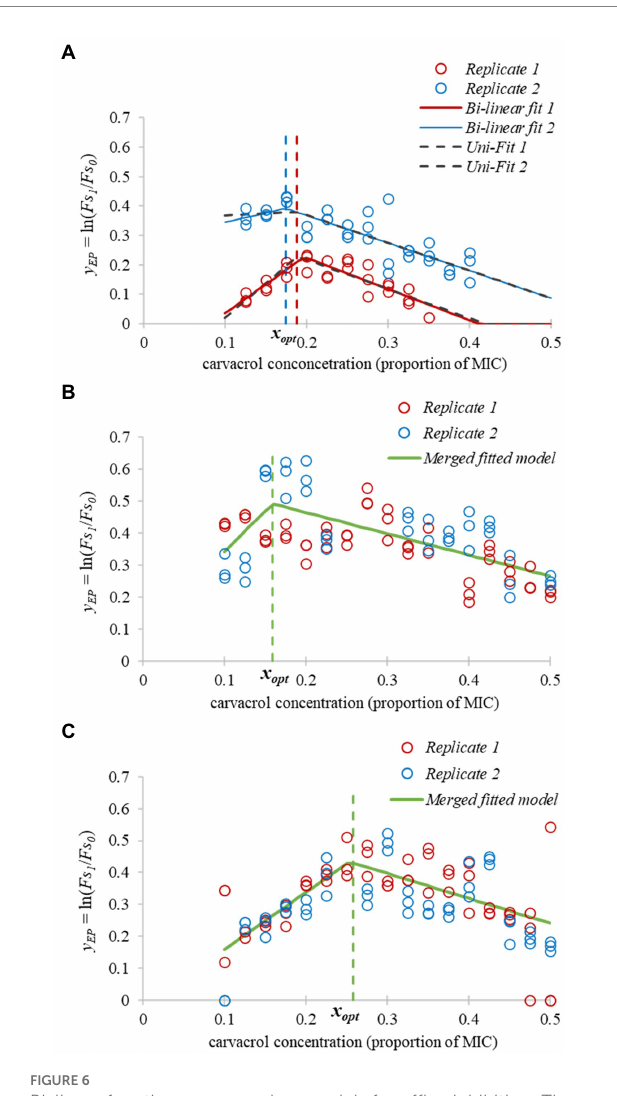
FIGURE 6 Bi-linear functions as secondary models for efflux inhibition. The chosen parameter of the primary model fitting was l )n ( / 1 0 = y Fs Fs EP , measuring the influence of carvacrol on the efflux mechanism via EtBr accumulation. Numbers indicate physiological states; (A) – fast-growing, (B) – slow-growing, and (C) – non-growing cultures of E. coli ATCC 11229. The x opt refers to the optimum concentration of carvacrol, where the efflux inhibition is the highest.